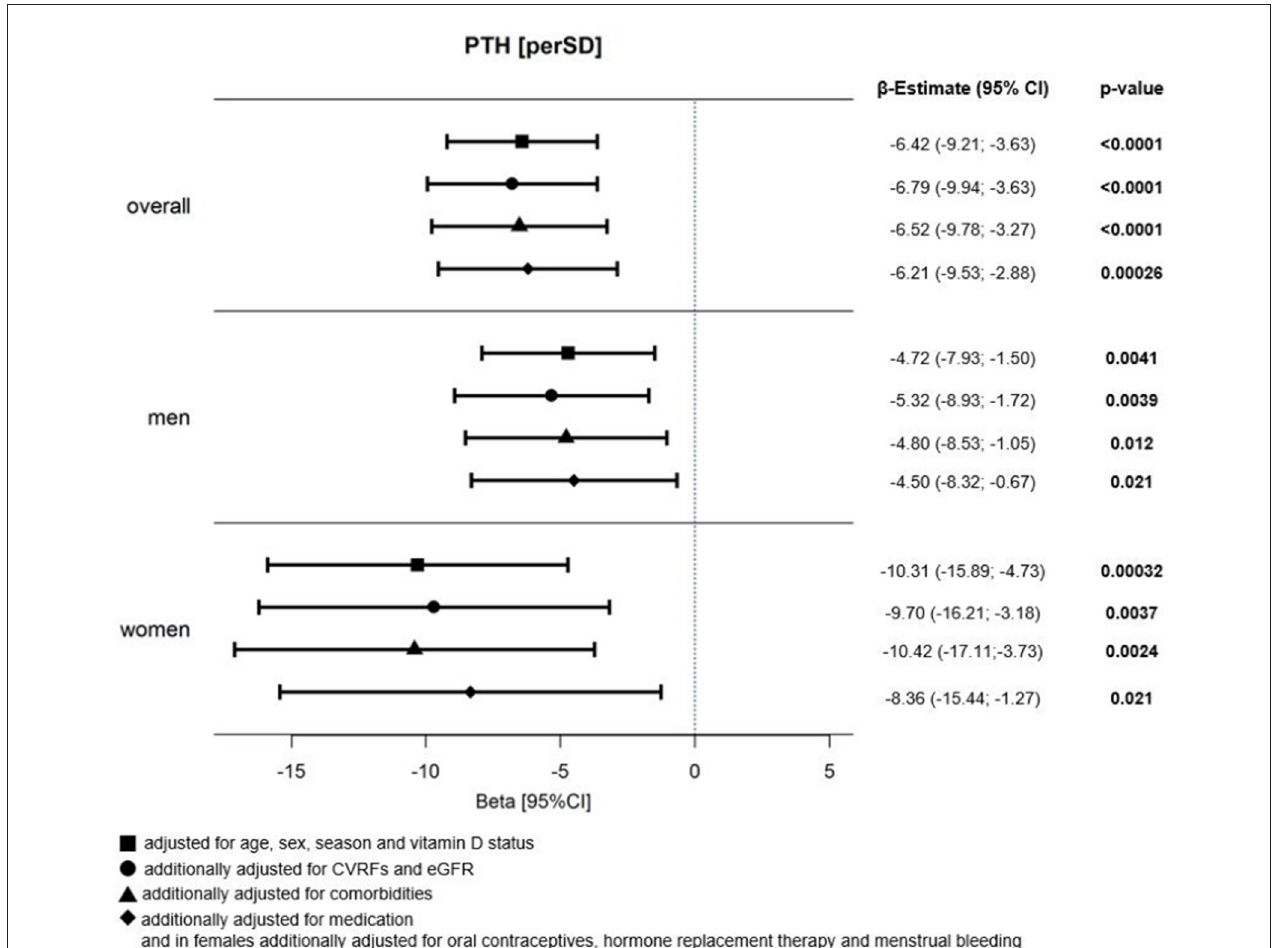
FIGURE 3 | Relation between platelet count and PTH in HF individuals. Forest Plot of beta ( β )-estimates with 95% confidence intervals (CIs) for the relation between platelet count and PTH in all HF individuals and stratified by sex. N (total analysis sample) = 1,860, thereof N = 532 females and N = 1,328 males; adjustment for sex only in overall analysis sample; PTH, parathyroid hormone; CVRFs, cardiovascular risk factors; eGFR, estimated glomerular filtration